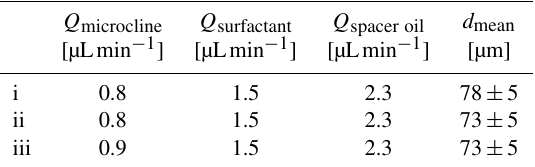
Table 2. Microcline suspension, surfactant in oil, and spacer oil flow rates used to produce each population of droplets for the hetero- geneous freezing experiments. The mean diameter of droplets ob- tained from the captured high-speed video is also summarized for each droplet population. Q microcline